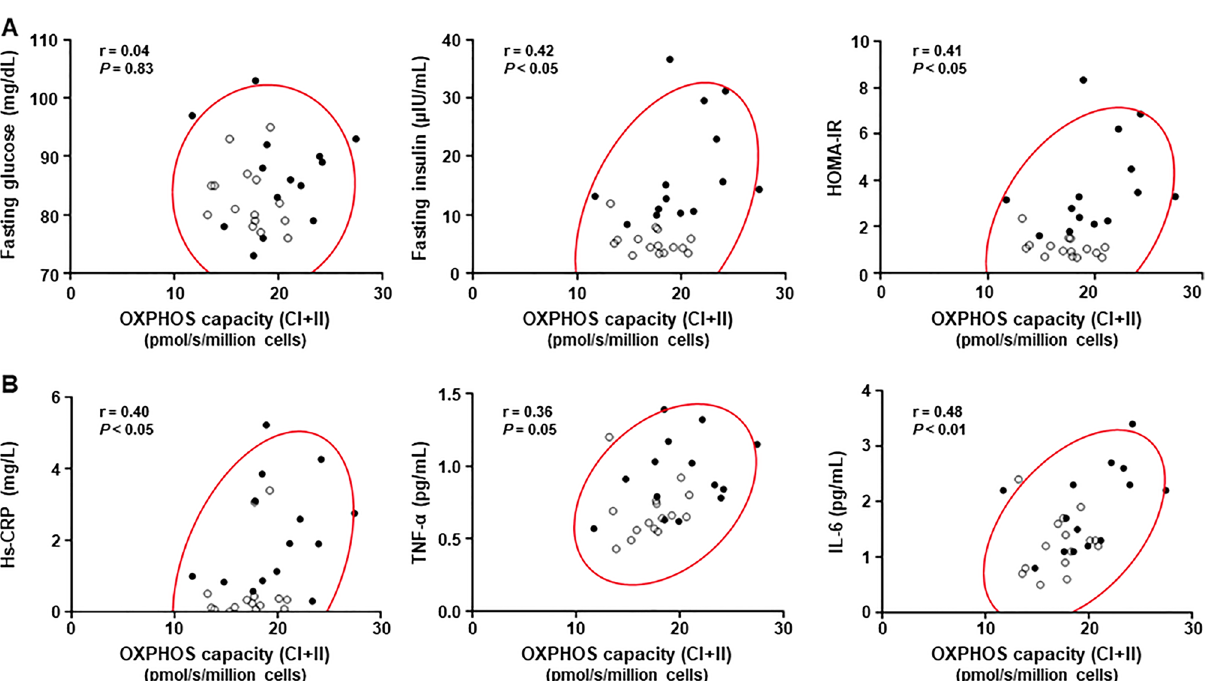
Figure 3. Relationships of mitochondrial respiratory capacity in PBMCs with insulin resistance and systemic inflammation. Linear relations of the mitochondrial OXPHOS capacity with complex I + II-linked substrates (i.e., maximal OXPHOS capacity) in the PBMCs with parameters of insulin sensitivity ( A ) and systemic inflammation ( B ) in all subjects. Obese subjects (n = 14): black circles . Healthy subjects (n = 15): white circles . A 95% confidence ellipse ( red colored ) is shown in each scatter plot. OXPHOS oxidative phosphorylation, HOMA-IR homeostasis model assessment of insulin resistance, hs-CRP high-sensitive C-reactive protein, TNF-α tumor necrosis factor-α, IL-6